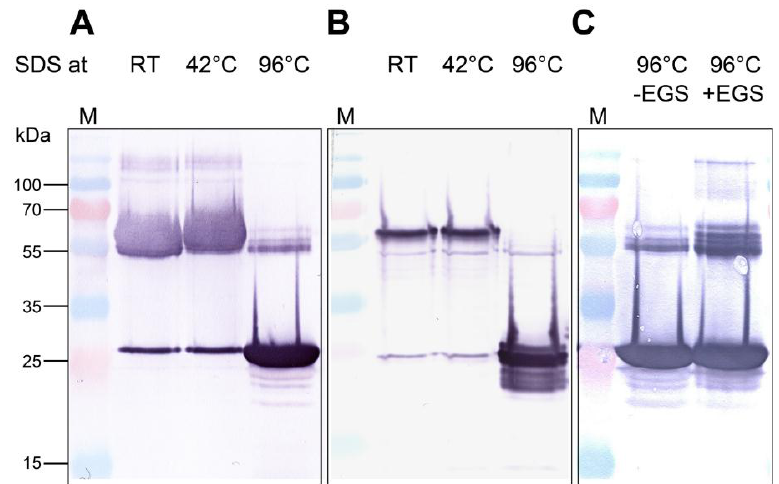
Figure 1. Recombinant Arabidopsis allene oxide cyclase 2 (AOC2) is a trimer. His-tagged proteins were purified on Ni-NTA, treated with SDS at given temperatures for 5 min and separated by SDS-PAGE. Detection of proteins was performed by immunolabeling using an anti-His-tag antibody. ( A ) Recombinant AOC2 protein with N-terminal His-tag; ( B ) recombinant AOC2 protein with C-terminal His-tag; ( C ) recombinant AOC2 protein with N-terminal His-tag cross-linked or not with 200 μM glycol-bis(succinic acid N -hydroxysuccinimide ester) (EGS) for 40 min. Note that only treatment at 96 °C resulted in the predominant occurrence of monomers (~26 kDa), whereas trimers resisted treatments at lower temperatures. Accordingly, cross-linking with EGS prevented separation of trimers by SDS treatment at 96 °C (C). M = size marker.